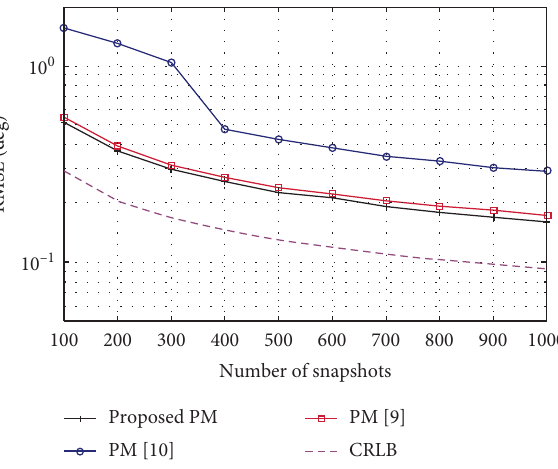
Figure 7: RMSE of three PM algorithms versus the number of